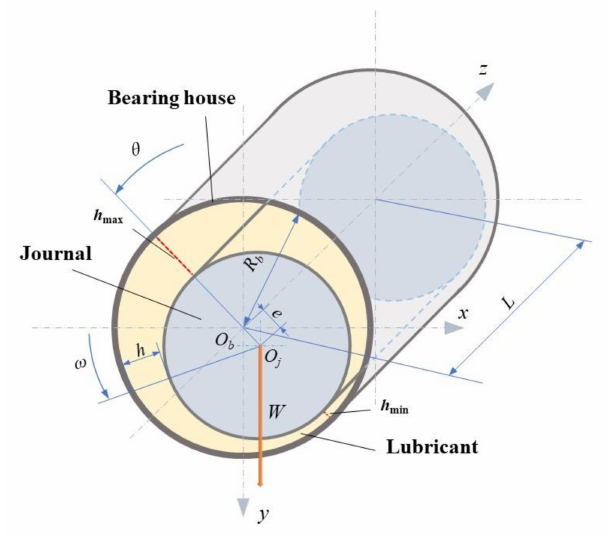
Figure 1. Schematic diagram of HJB